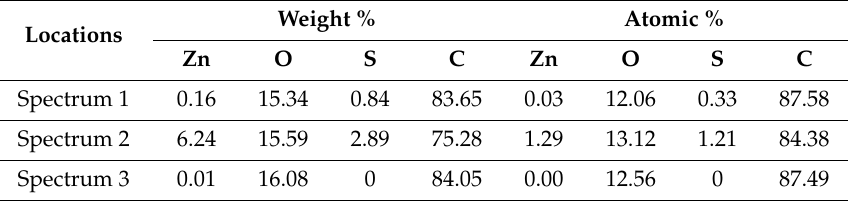
Table 1. EDS analysis of the ZnO/ZnS core–shell/CNT nanostructures.